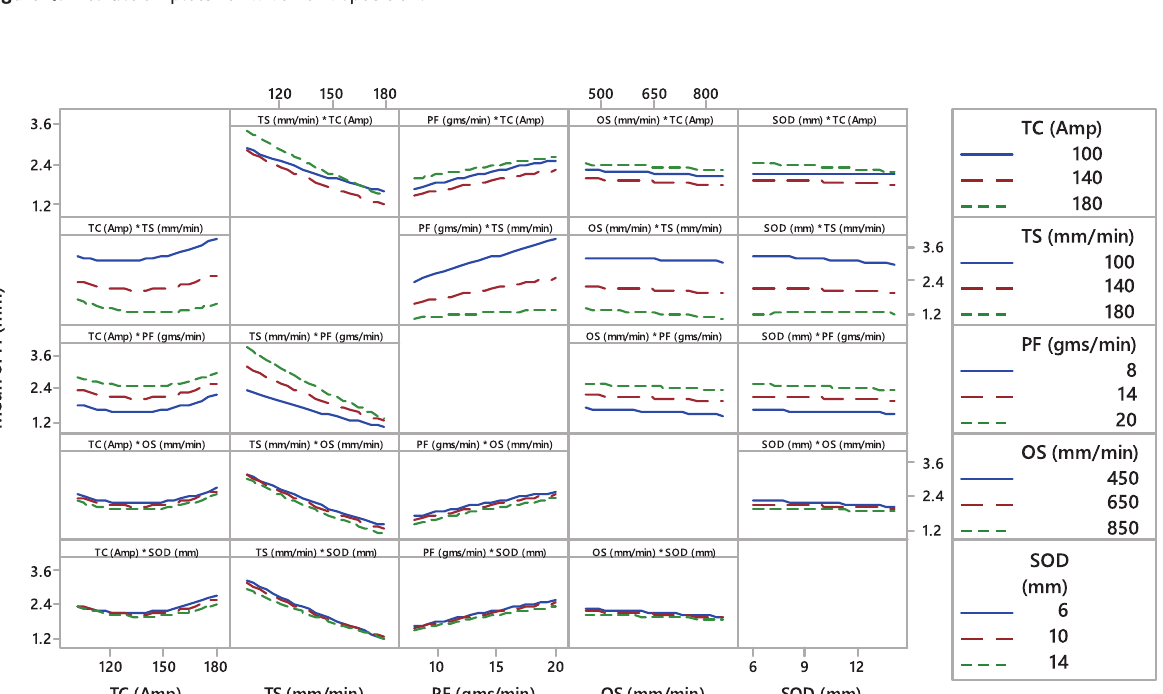
Figure 4: Interaction plots for width of deposition.